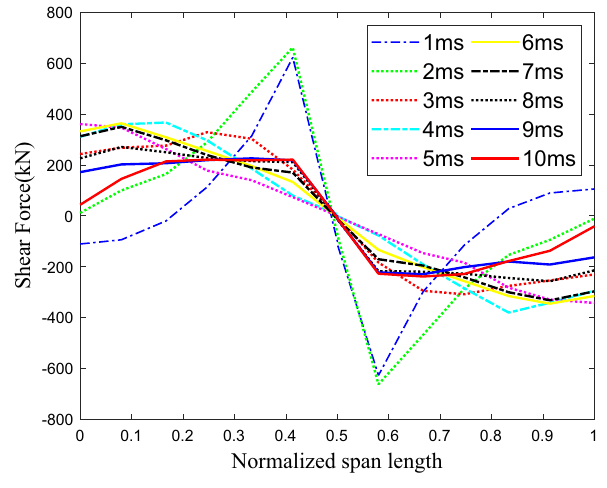
Fig. 10 Dynamic shear force diagram